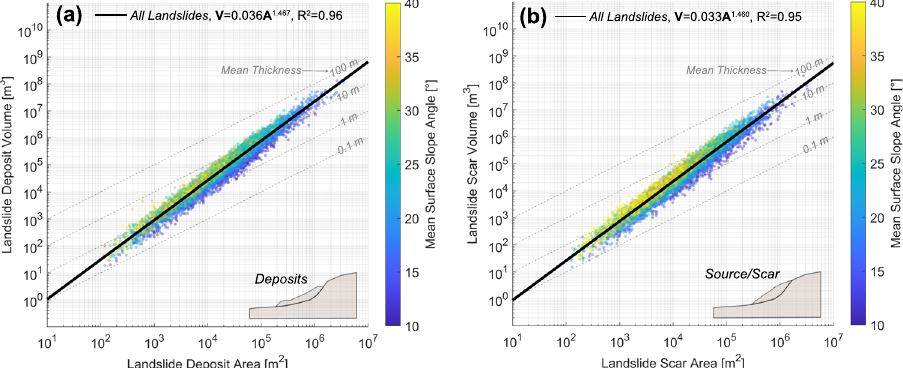
Fig. 1 | Scaling relationships for aggregated landslide inventories in Western Oregon used in this study ( n =7330 landslides). a Landslide Area-Volume power law fi ts are shown for landslides based on existing deposit topography ( V =0.036A 1.467 , R 2 =0.96, RMSE=0.217). Data points are sorted and colored by mean hillslope inclination, showing anassociation of steeper slopes within smaller landslide areas. b Landslide Area-Volume power law fi ts are shown for inferred